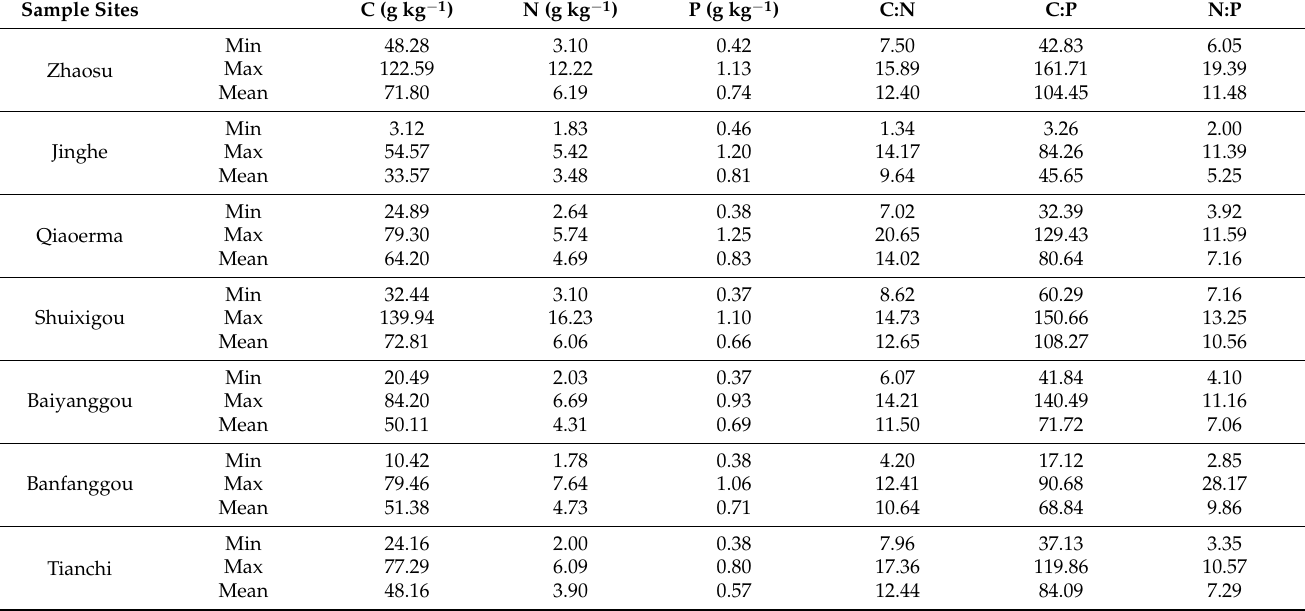
Table 3. Statistics of soil ecological stoichiometry at sampling sites.